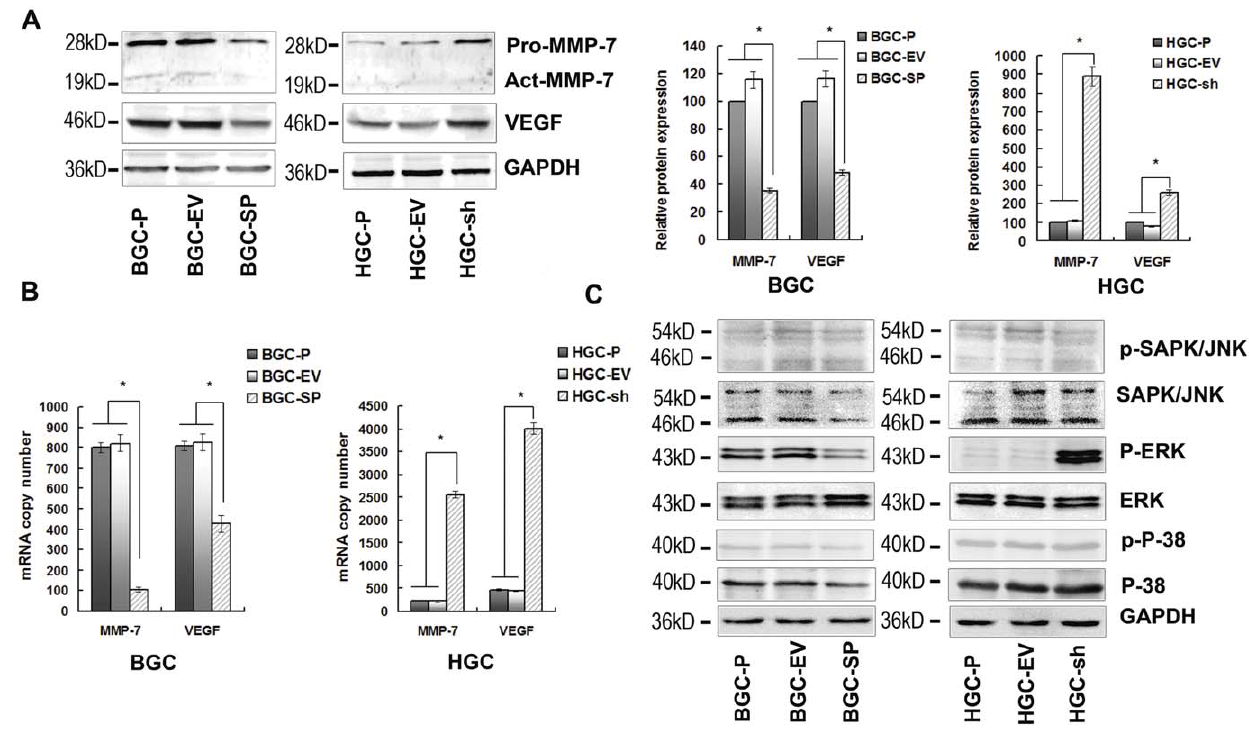
Figure 3. The MAPKs signalling pathway and expression of VEGF and MMP-7 are decreased by SPARC overexpression. ( A ) Cell lysates were used to perform western blotting analysis for VEGF and MMP-7 expression. GAPDH served as loading control. The expressions of VEGF and MMP-7 were declined at protein level in BGC-SP cells. The expressions of VEGF and MMP-7 were increased at protein level in HGC-sh cells. Columns are means ( 6 s.d.) of triplicate experiments; *P , 0.05, significant difference from control cells. ( B ) Real-time PCR was performed for assessment of VEGF and MMP-7 mRNA transcript levels. GAPDH served as a loading calibration. Columns are means ( 6 s.d.) of triplicate experiments; *P , 0.05, significant difference from control cells. ( C ) Cell lysates were used to perform western blotting analysis for molecules in MAPK signalling pathway. The activation of ERK1/2 was inhibited in BGC-SP cells compared with control cells, however, ERK1/2 was activated in HGC-sh cells compared with control